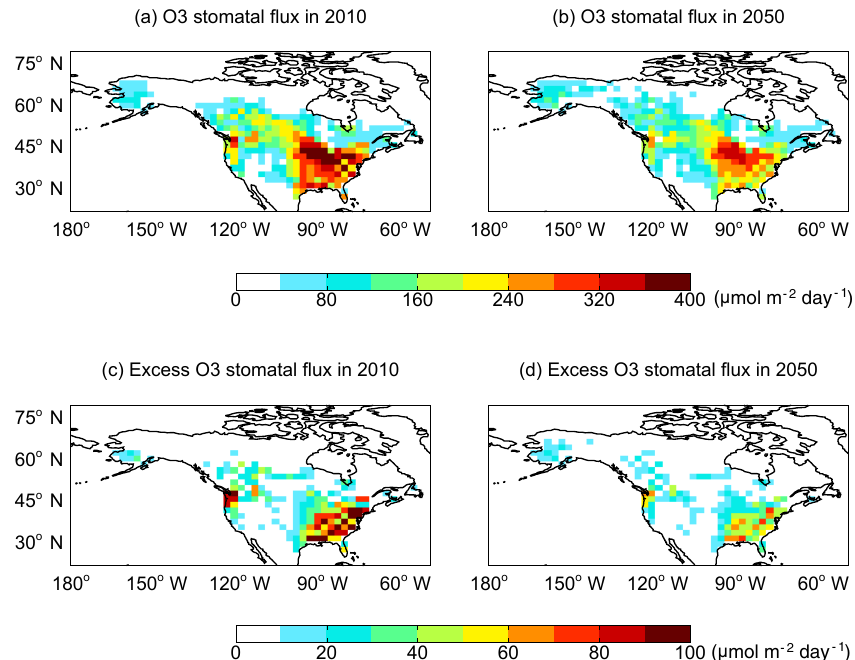
Figure 8. Simulated summertime O 3 stomatal fluxes in boreal North America. Results shown are the (a, b) mean and (c, d) excess flux at (a, c) 2010 and (b, d) 2050. Simulated [O 3 ] includes contributions from both wildfire and non-fire emissions. Excess O 3 stomatal flux is calculated as the difference between the stomatal flux and a PFT-specific threshold as defined in Sitch et al. (2007).